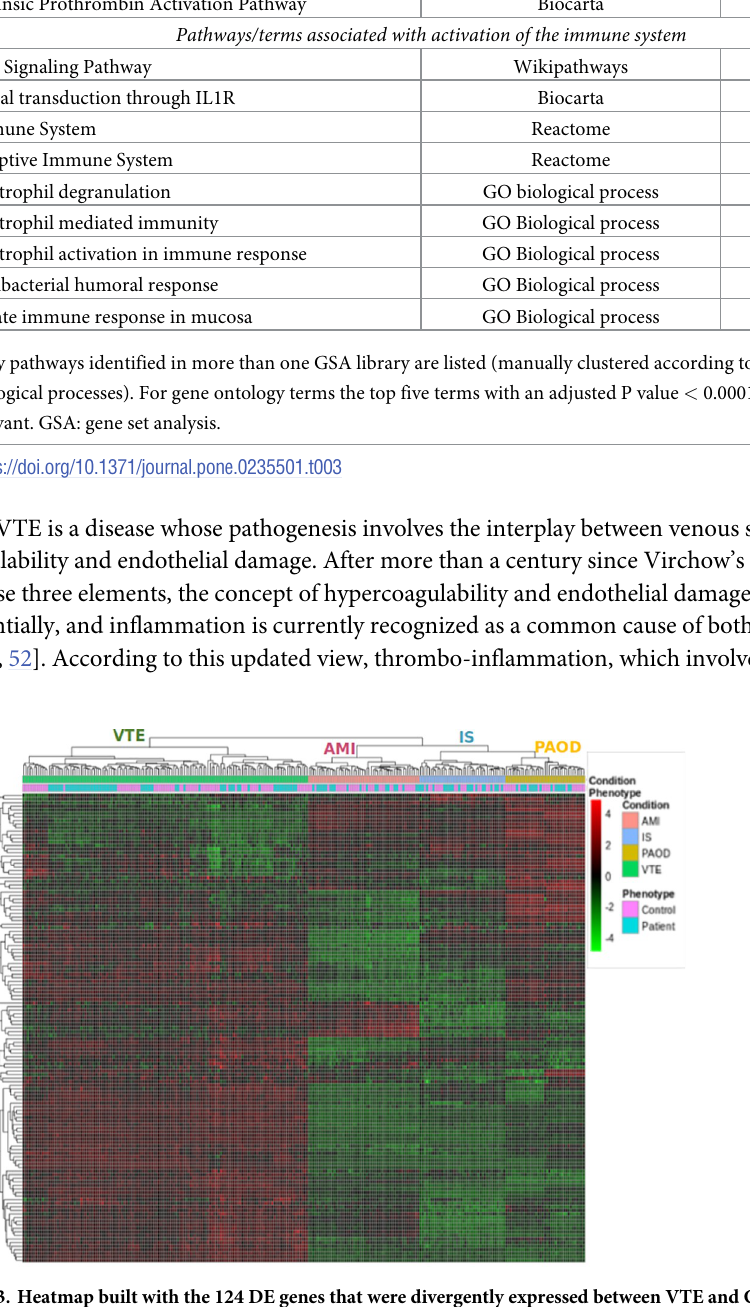
Table 3. Pathways and ontology terms enriched in the meta-analysis of VTE and CVD.